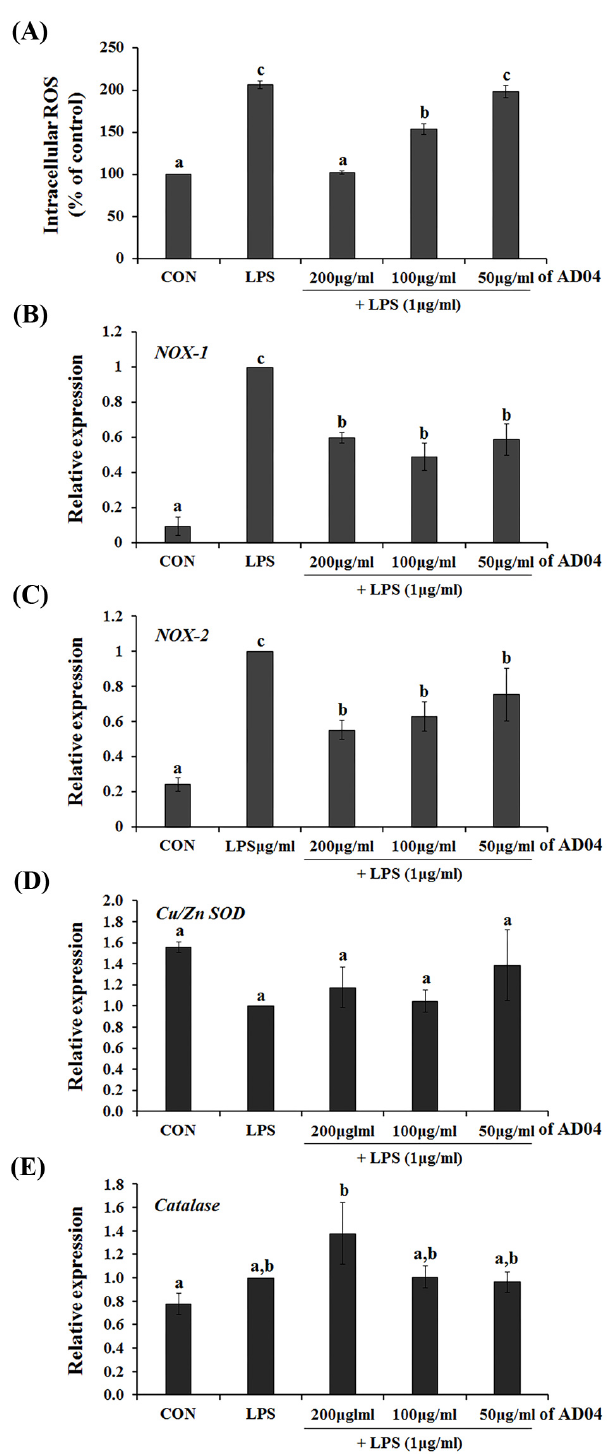
Fig. 6: Effects of BuOH fraction (AD04) on the production of LPS-induced ROS in RAW264.7 cells. (A) The LPS-induced intracellular ROS level was analyzed using the fluorescent probe DCF-DA. LPS- stimulated RAW 264.7 cells in the presence of AD04 were used to measure the mRNA levels of NOX-1 (B) and -2 (C) and those of Cu/ Zn SOD (D) and catalase (E) by qRT-PCR. The relative amounts of transcripts were normalized to the levels of β-actin within the same sample. The value for the LPS-stimulated cells was set to 1.0. The average of three independent experiments is shown, and the error bars indicate the SD. Mean separation within columns by Duncan’s multiple range test is p <